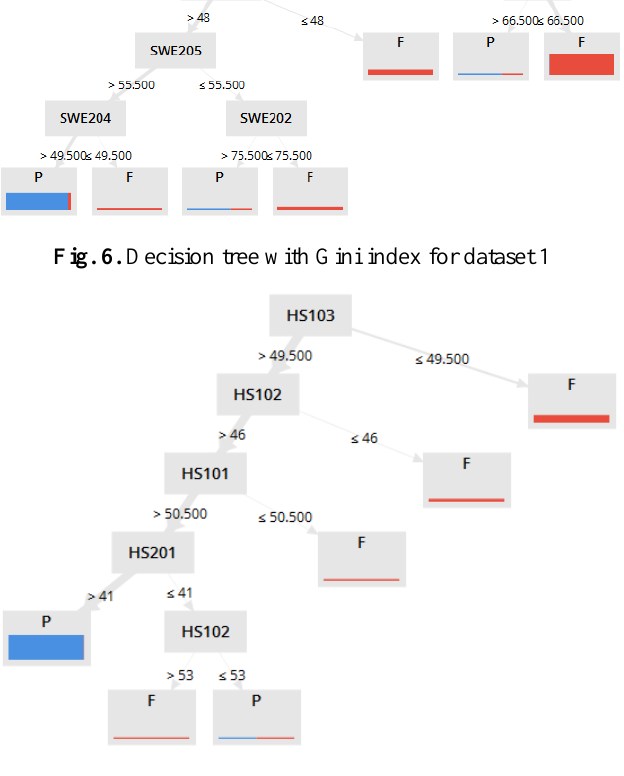
Fig. 7. Decision tree with gain ratio for dataset 1